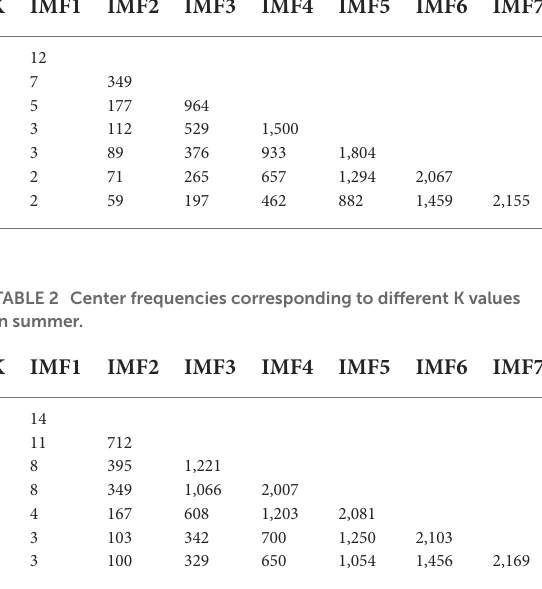
TABLE 6 Evaluation index of five prediction models in test